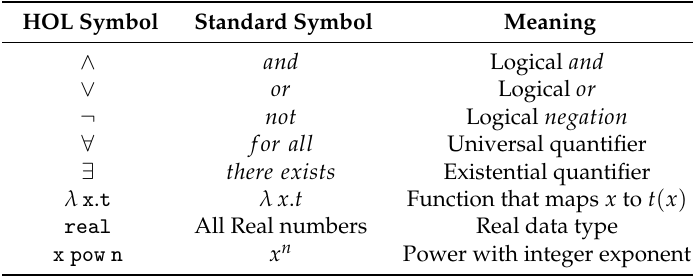
Table 1. HOL-Light symbols and